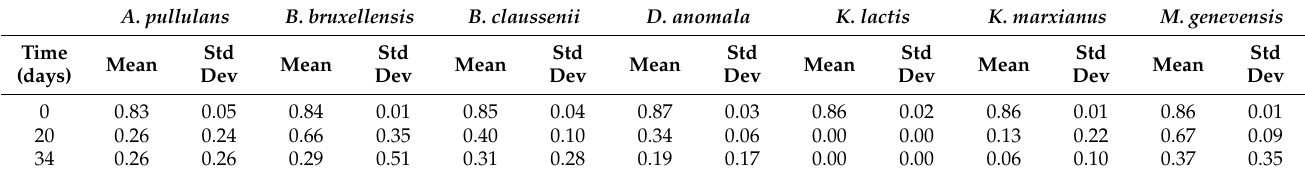
Table 7. Lactic acid concentrations under aerobic fermentation